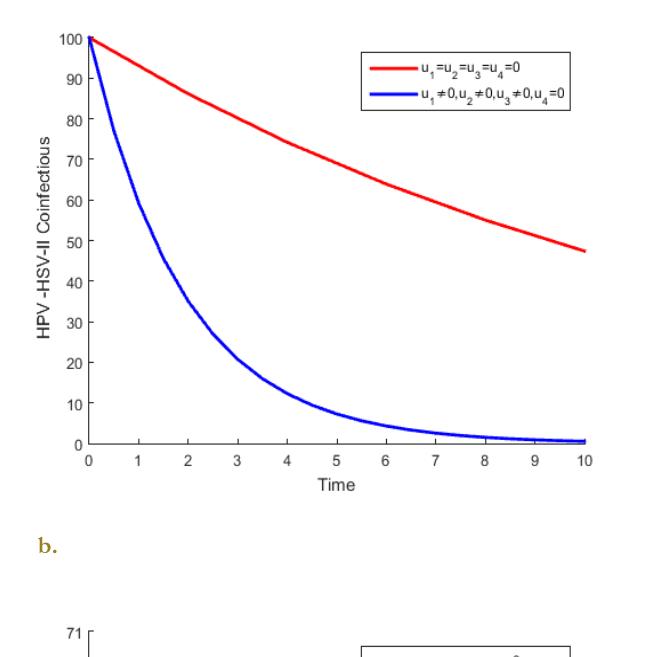
b. Fig. 4. Simulations showing optimal use of HPV prevention, HSV-II prevention and HPV treatment.